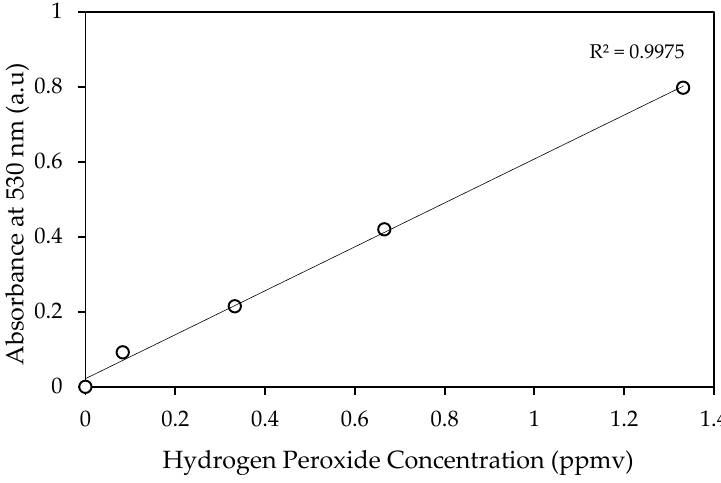
Figure 14. Calibration curve of H 2 O 2 measurements by colorimetric method.